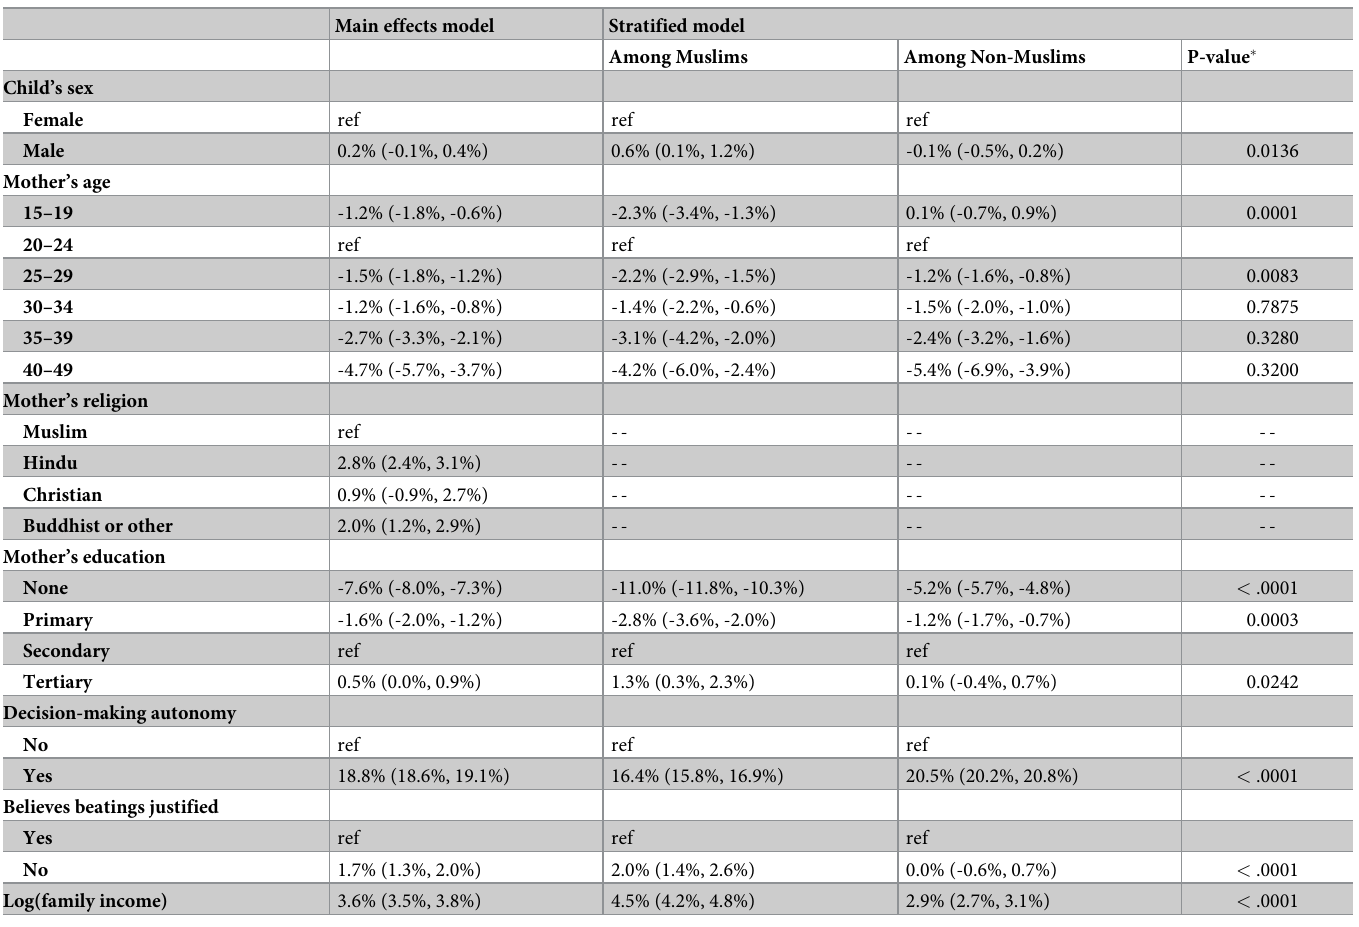
Table 4. Predictors of composite coverage index (CCI) among mothers of children 12–23 months old in South